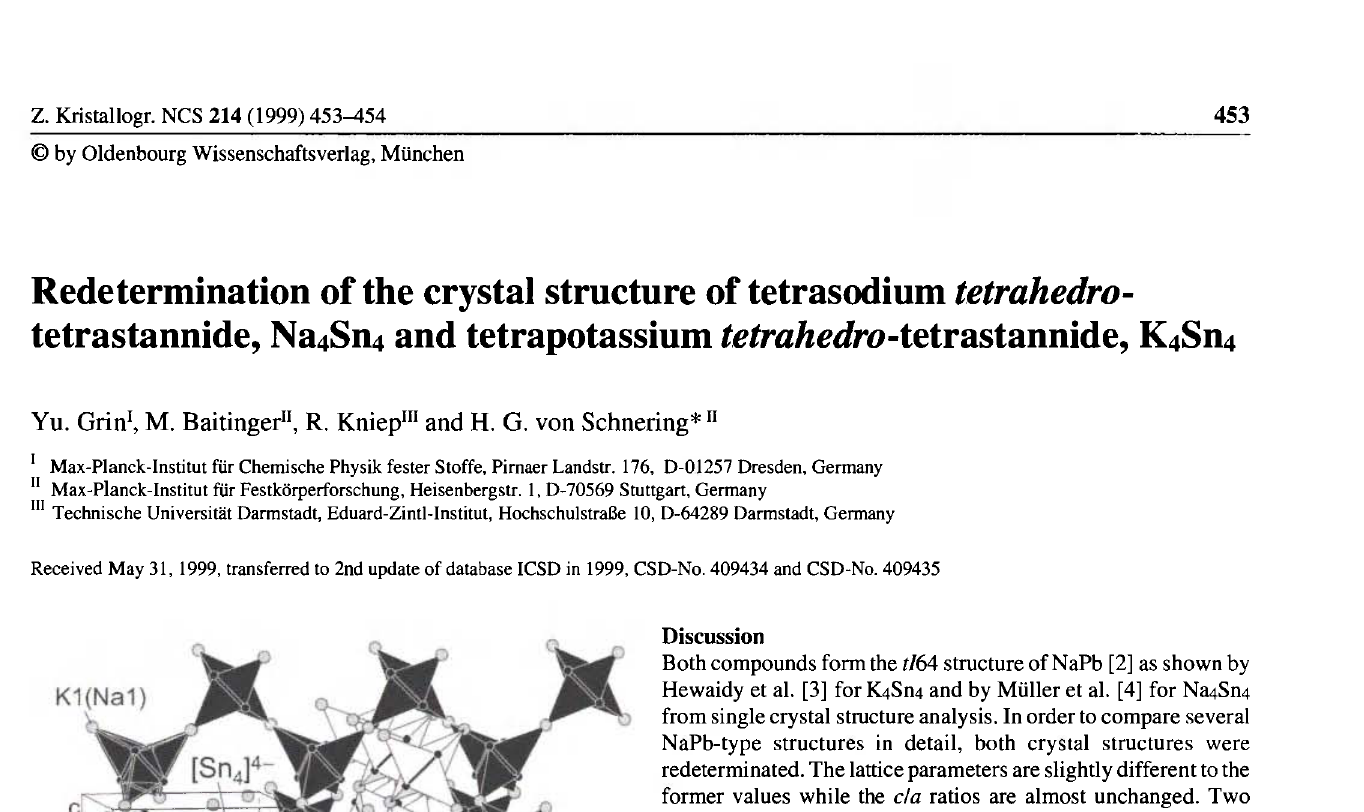
Table 1. Data collection and handling.